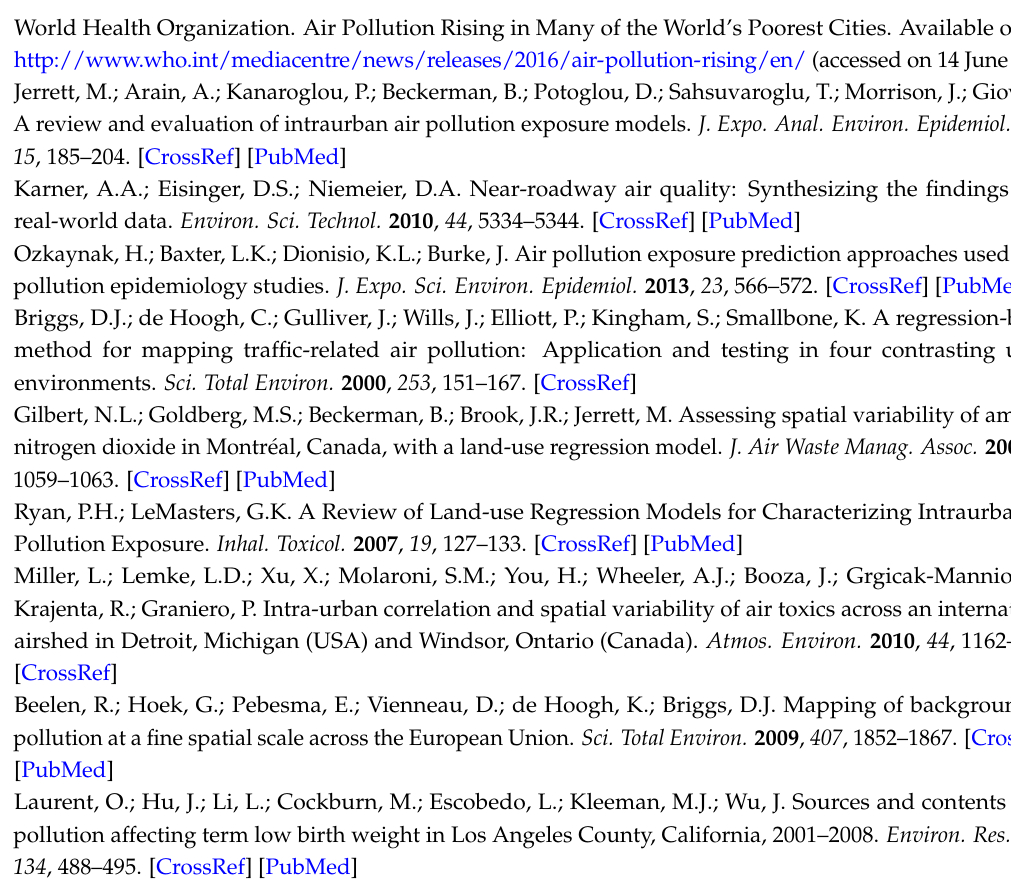
Table S1: NLCD land use/land cover categories; Table S2: BenMAP health impact and valuation functions used in this study; Table S3: Performance metrics for the summer and winter LURF and LUR models using 10-fold validation; Table S4: Economic valuation of LULC-related NO 2 health impacts; Table S5: Modeled mean and median of the NO 2 (over study area) from a sensitivity analysis; Figure S1: % difference in NO 2 as estimated using the biased and bias-corrected LURF models; Figure S2: LURF NO 2 -LUR NO 2 plot and best fit line. Acknowledgments: The authors gratefully acknowledge support for part of this research from the U.S. Forest Service Award #2011-DG-11062765-016. Meenakshi Rao would like to acknowledge support from the Edward D. and Olive C. Bushby scholarship. We would also like to thank the numerous volunteers who helped with the field campaigns and Scott Kiel who helped with the chemical analysis of the Ogawa